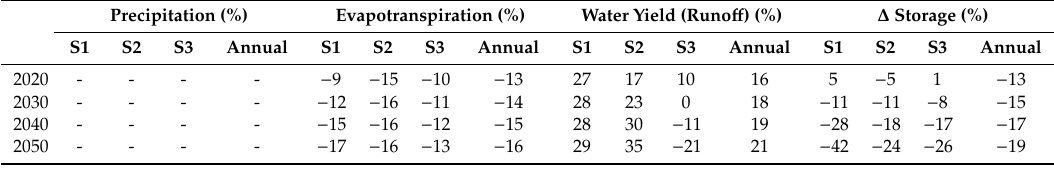
Table 5. Impacts of land use / cover change on hydrology considering baseline data of 2010. S1 is pre-monsoon season (March–May); S2 is monsoon season (June–September); and S3 is post-monsoon season (October–February).